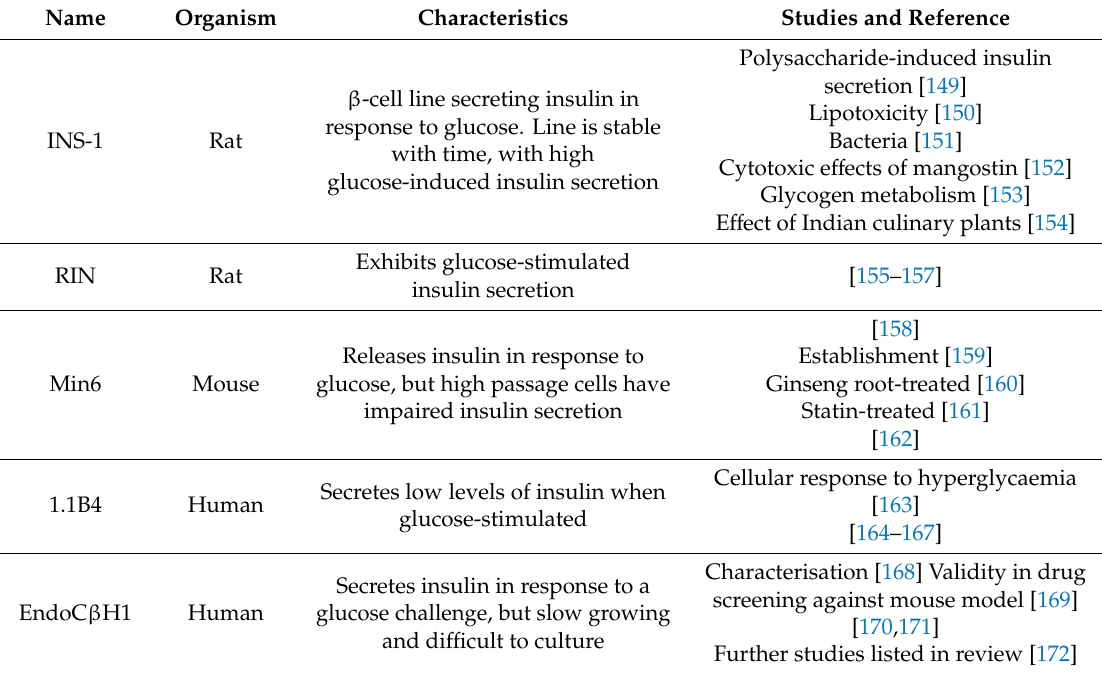
Table 1. Cell models used to study e ff ects on pancreatic β